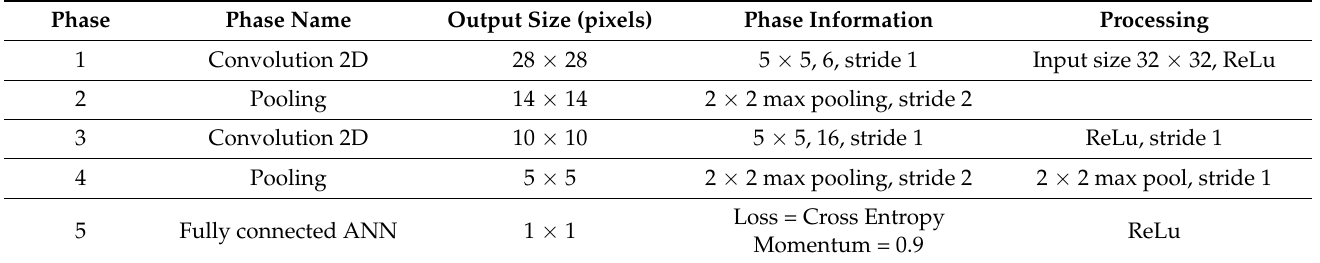
Table 1. Architecture of 5-phase convolutional neural network used in this study.